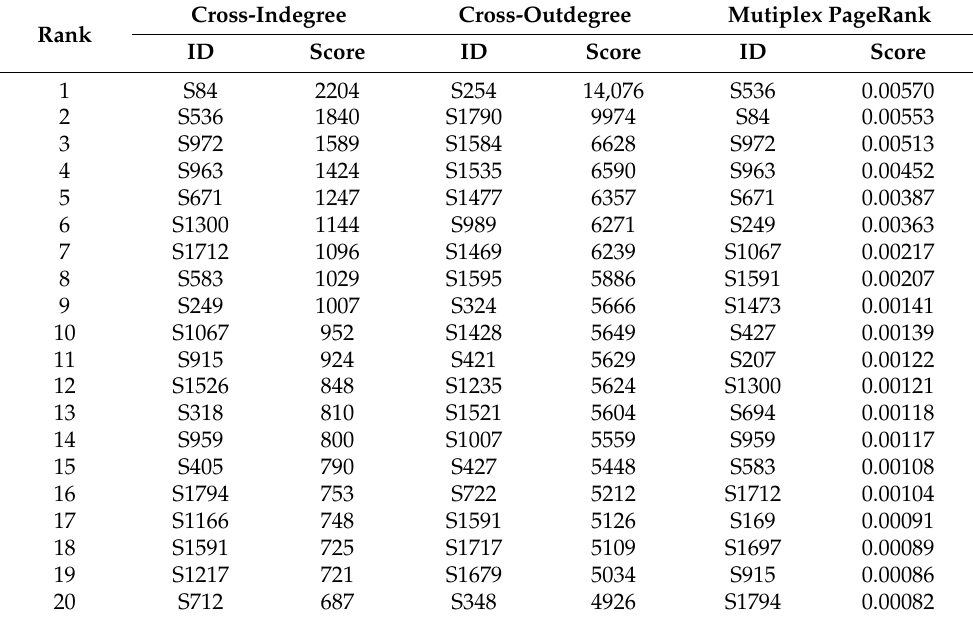
Table 3. Top 20 influential malicious accounts across layers of the